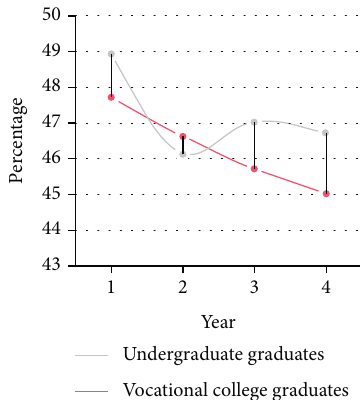
Figure 6: Business intention.